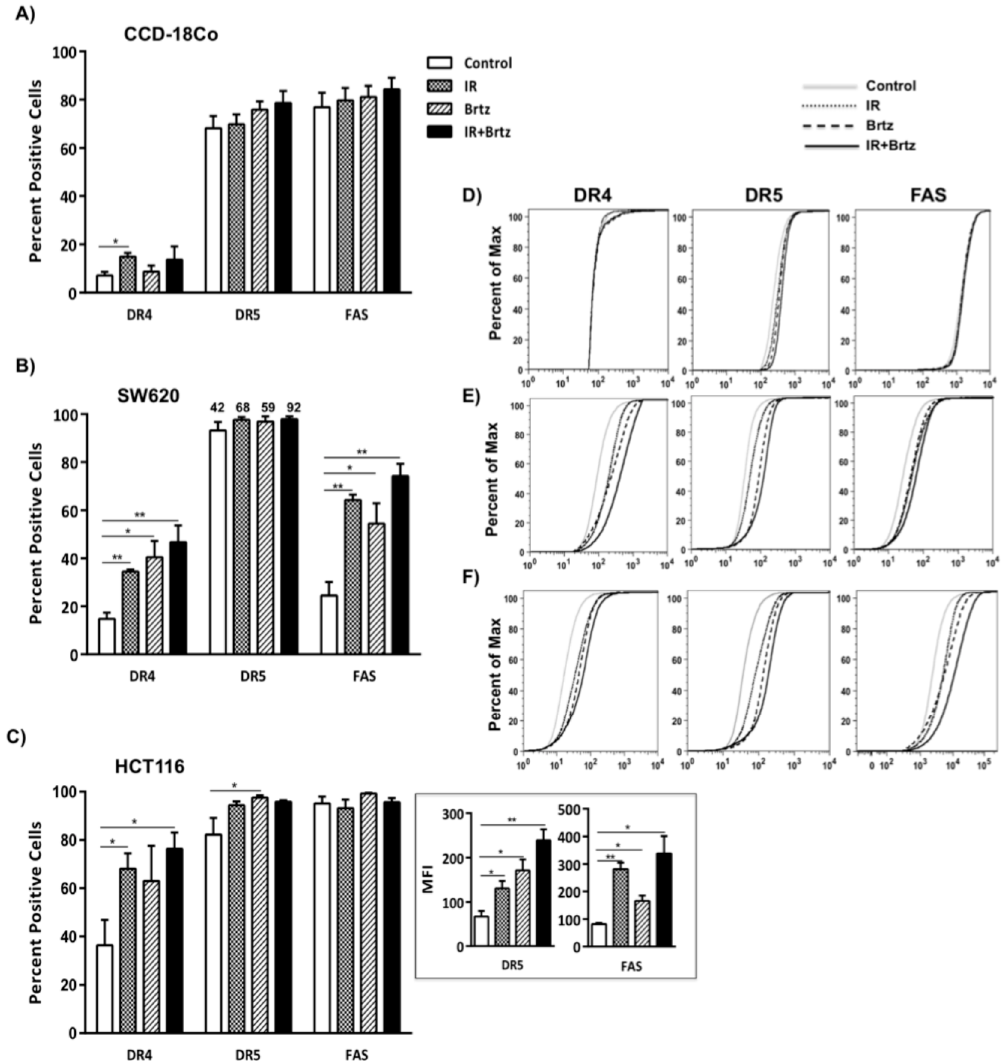
Figure 4. A combination treatment of sub-lethal dose of radiation and proteasome inhibition increases cell surface expression of death receptors. Following the treatments, cells were harvested and stained with PE-labeled antibody to human DR4, Fas or APC-labeled DR5. Cell surface protein expression was evaluated by flow cytometry. Isotype control stained cells were set to 5% positive. Graph represent average of three independent experiments, with error bars denoting SEM * p < 0.05, ** p < 0.005. Cells surface expression of DR4, DR5 and Fas in ( A ) CCD-18Co, ( B ) SW620 ( C ) and HTC116 cells. Representative cumulative distribution function (CDF) plots of DR4, DR5 and Fas expression in ( D ) CCD18Co, ( E ) SW620 and ( F ) HCT116 cells.